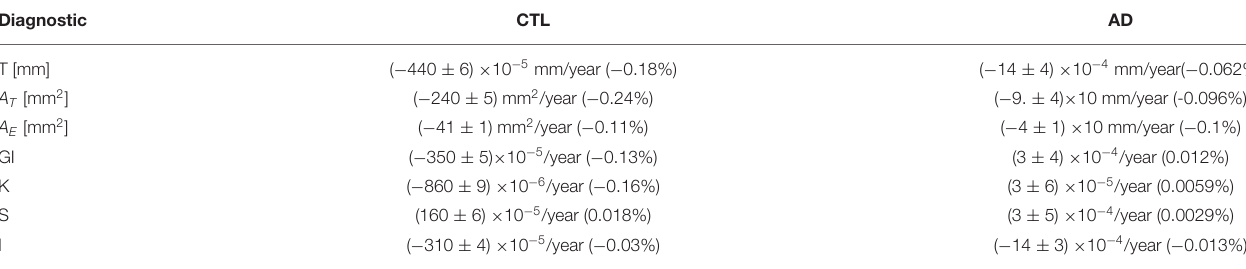
TABLE 3 | Changing rate per year for each variable (after harmonization) and diagnostic. Diagnostic